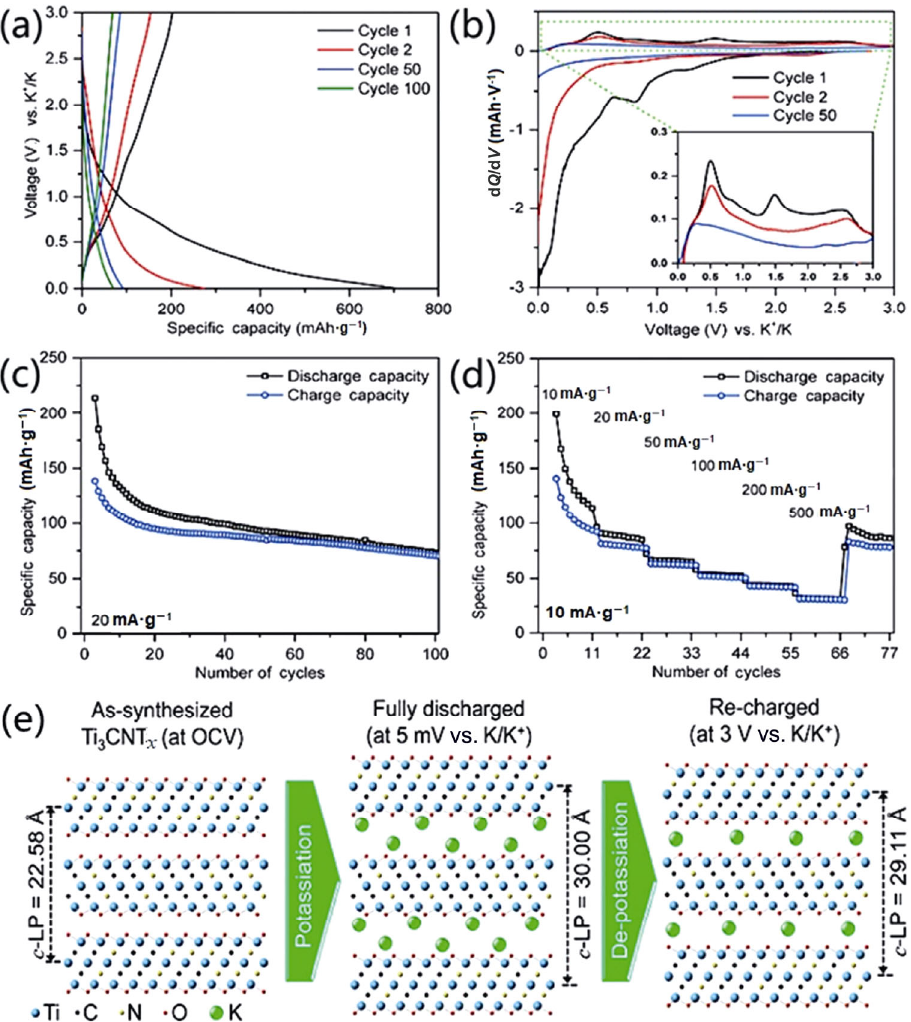
Fig. 25 (a–d) Electrochemical performance of the Ti 3 CNT x electrode. (e) Schematic for the structure of Ti 3 CNO 2 before and after electrochemical potassiation and de-potassiation. Reproduced with permission from Ref. [232], © Royal Society of Chemistry 2017